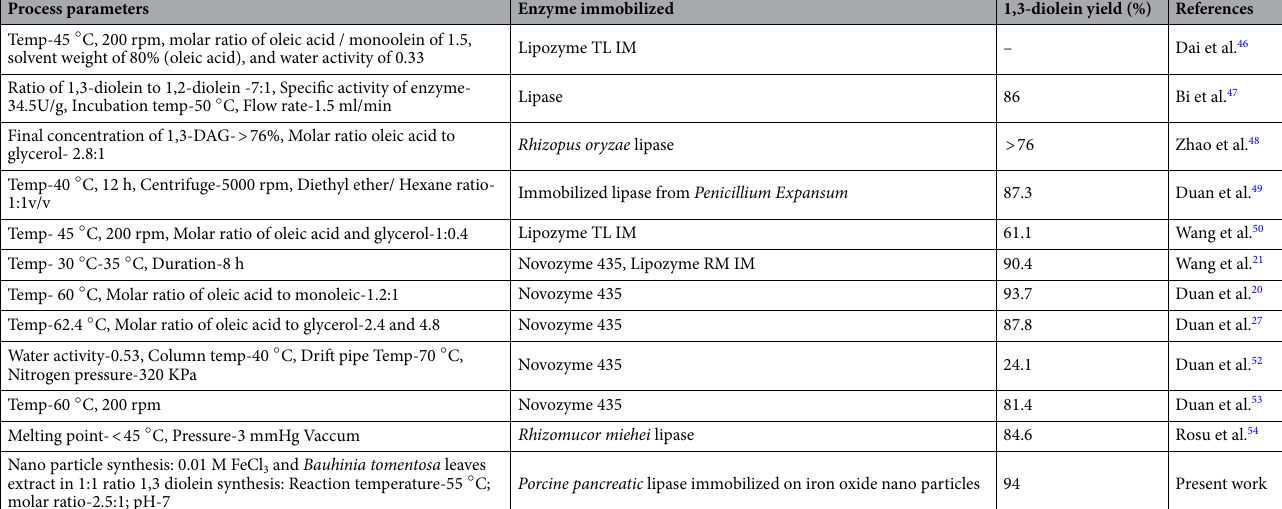
Table 2. The comparison of 1,3-diolein synthesis using free/immobilized lipase catalytic process reported in the literature with the present